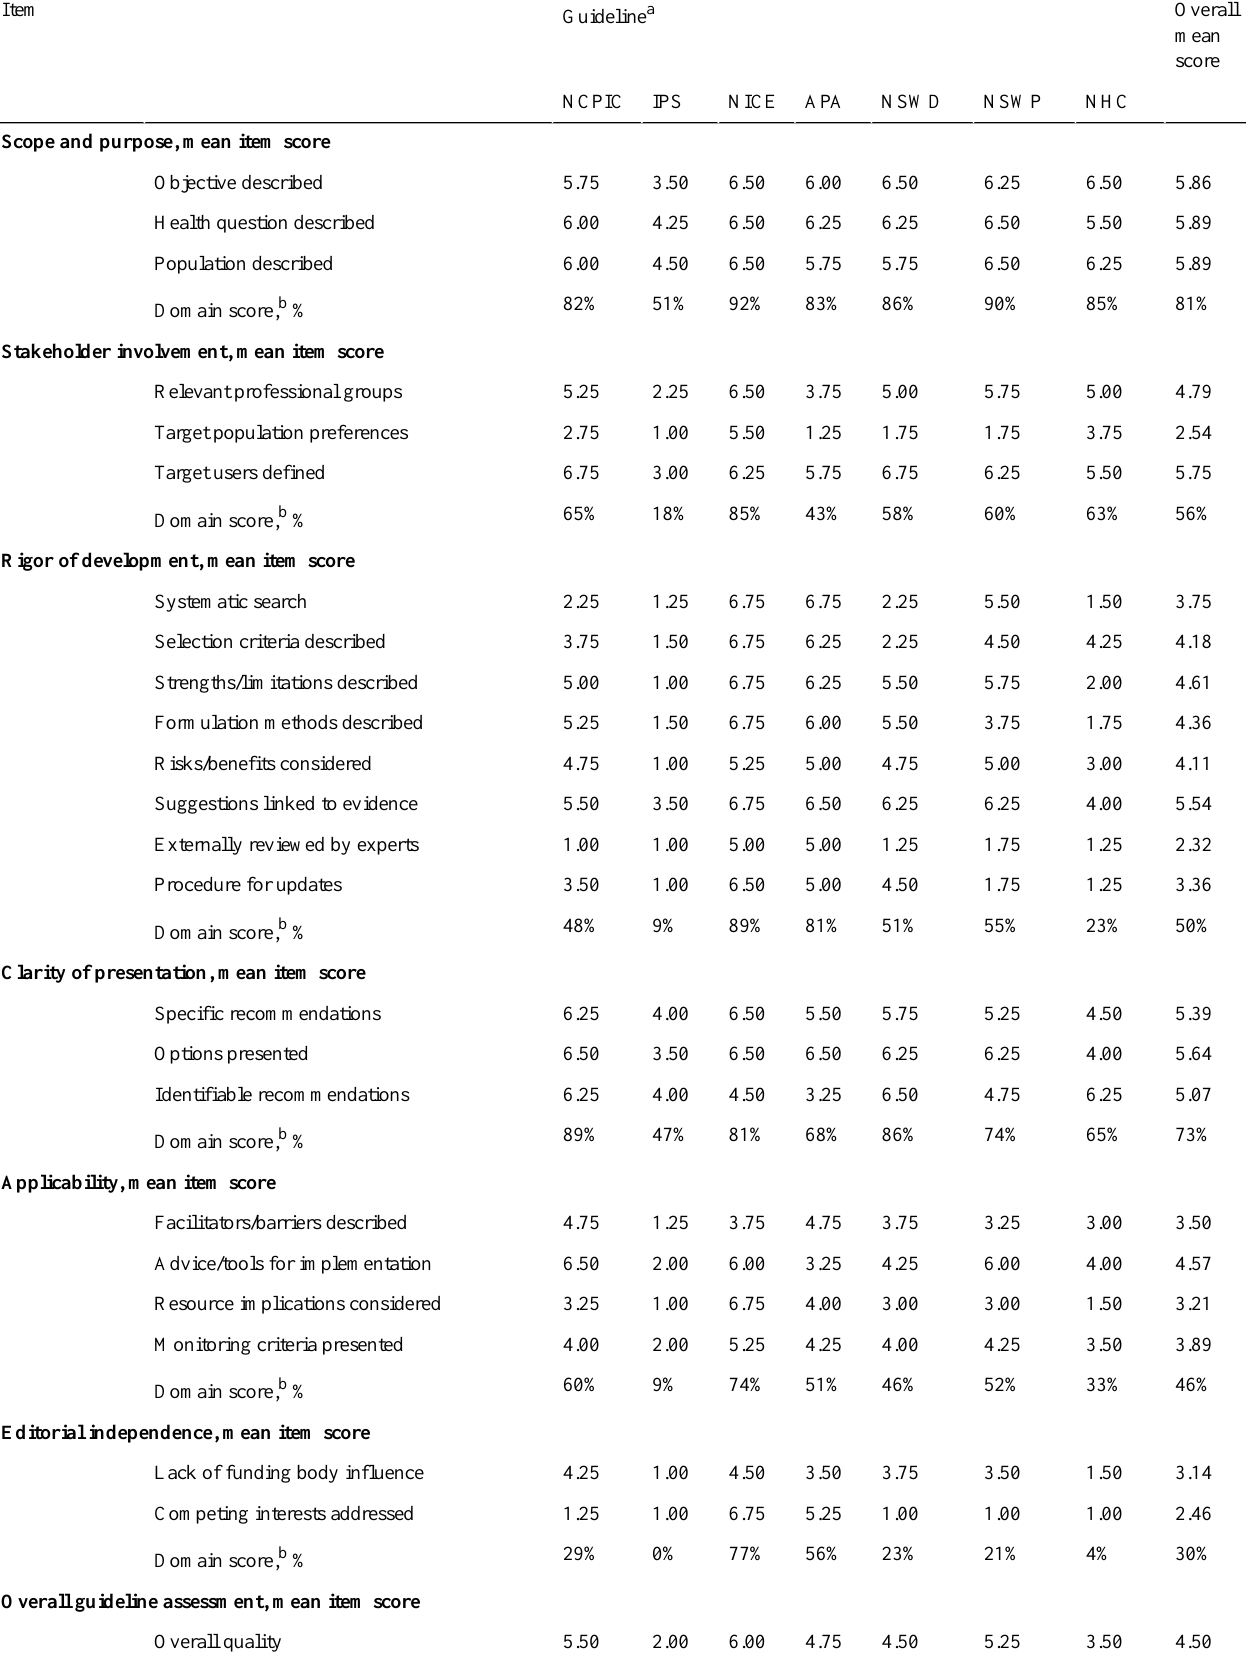
Table 2. AGREE II mean item scores and domain percentage scores for each